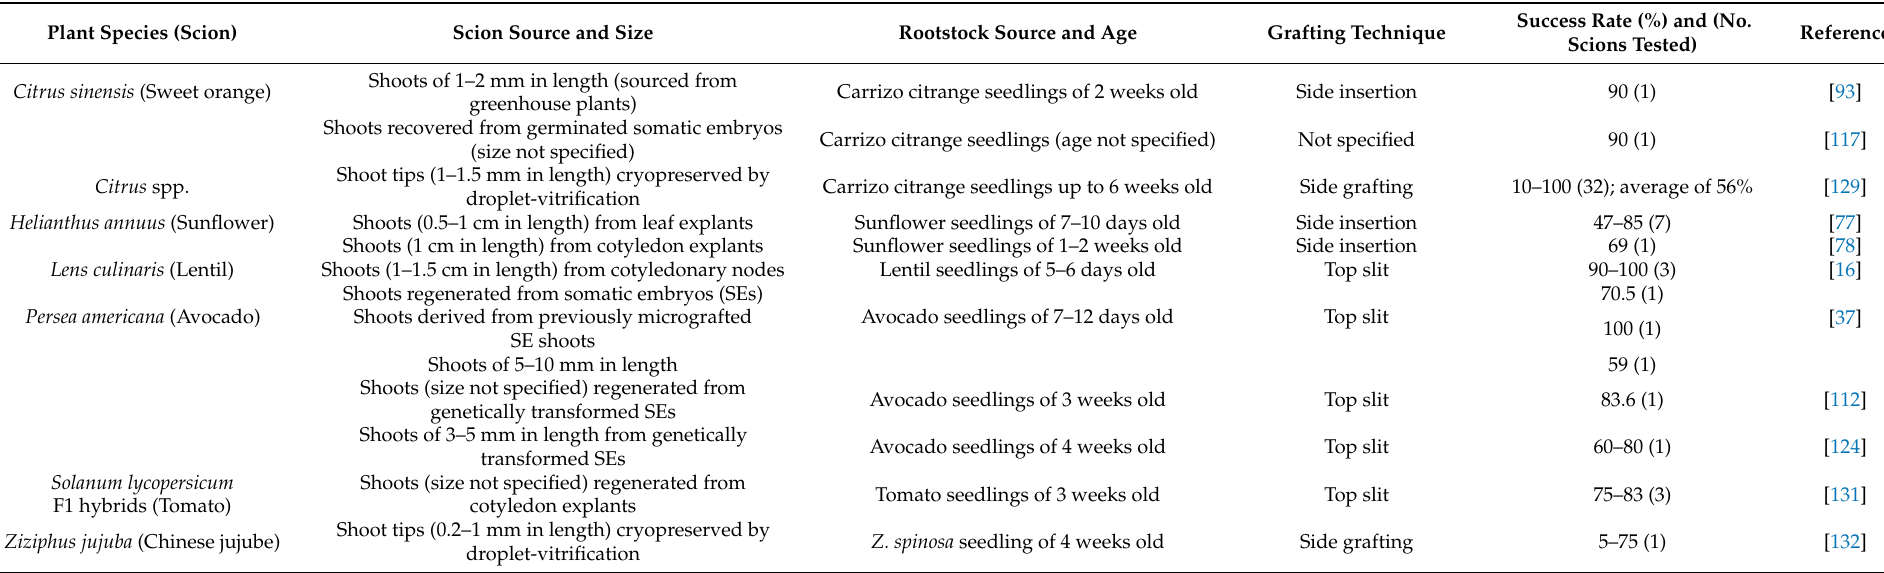
Table 2. Applications of in vitro micrografting in promoting of plants recovery after shoot organogenesis, somatic embryogenesis and shoot tip cryopreservation. Plant Species (Scion)